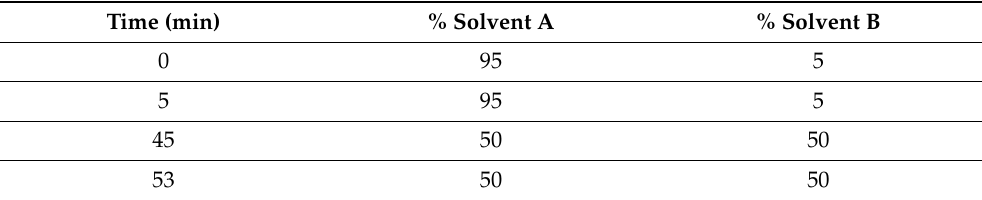
Table 1. Elution gradient employed in the HPLC